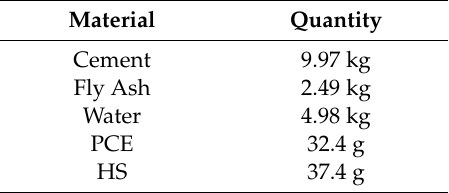
Table 3. Composition of 9 L of paste for the determination of the Krieger-Dougherty curves of the mortar mixtures.